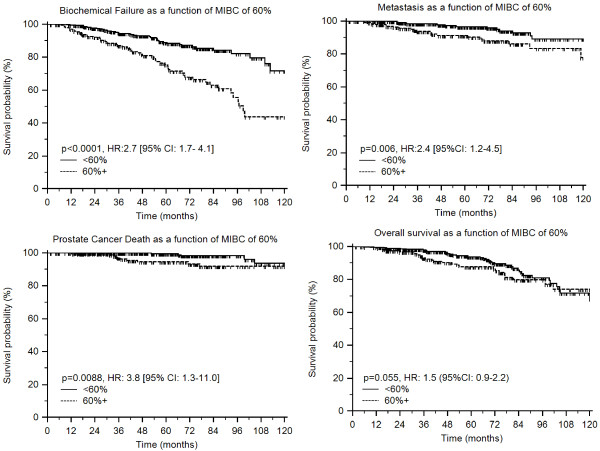
 Kaplan-Meier estimates of (a) freedom from biochemical failure, (b) freedom from metastasis, (c) cause-specific survival, and (d) overall survival as a function of maximum involvement of biopsy core (MIBC). Cut-point of 60% generated from receiver operating characteristic curve analysis.